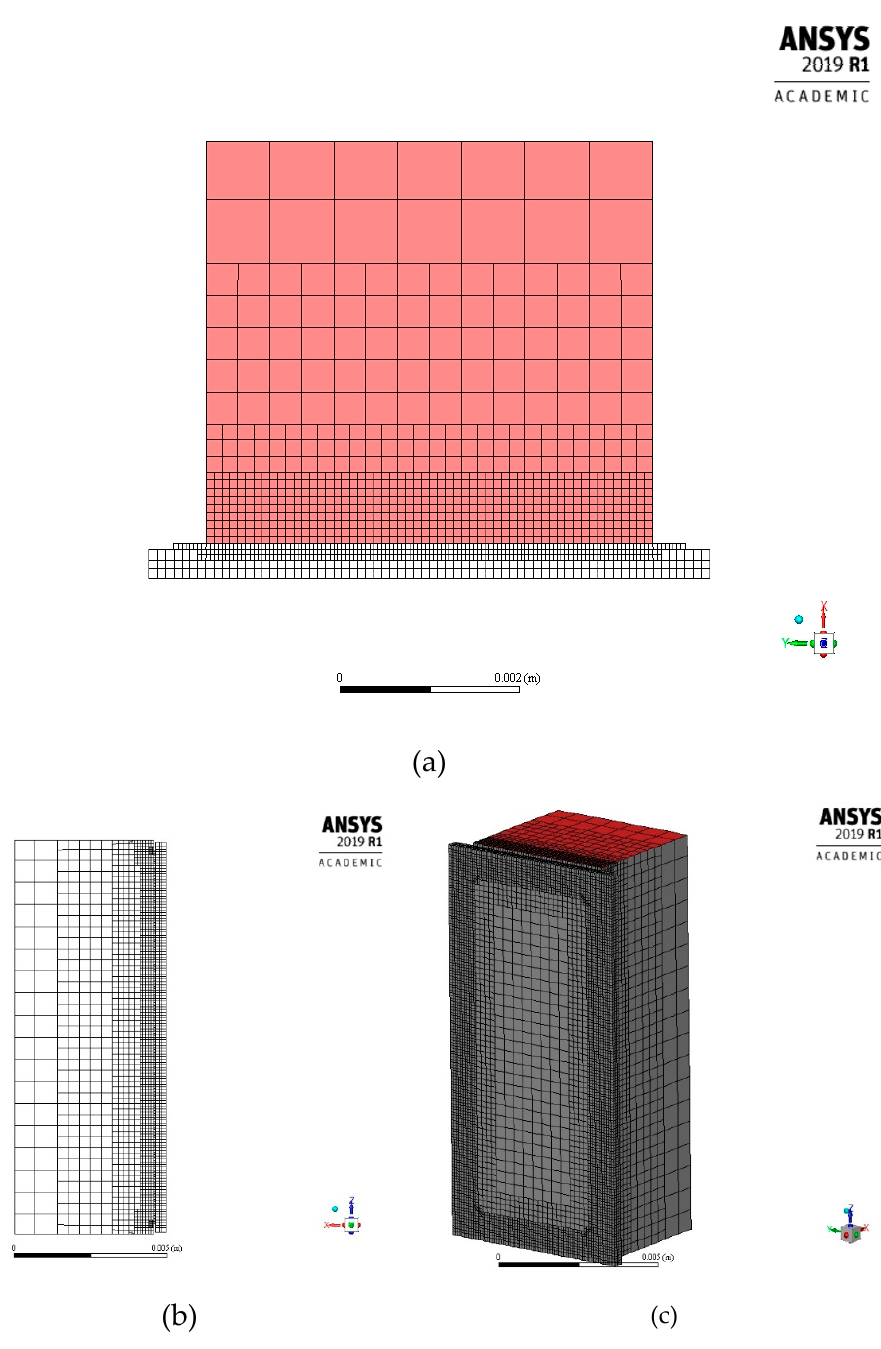
Figure 2. ( a ) A plan and view of the duct mesh on a case with duct width of 50 cm; ( b ) side view; (c) three dimensional view.